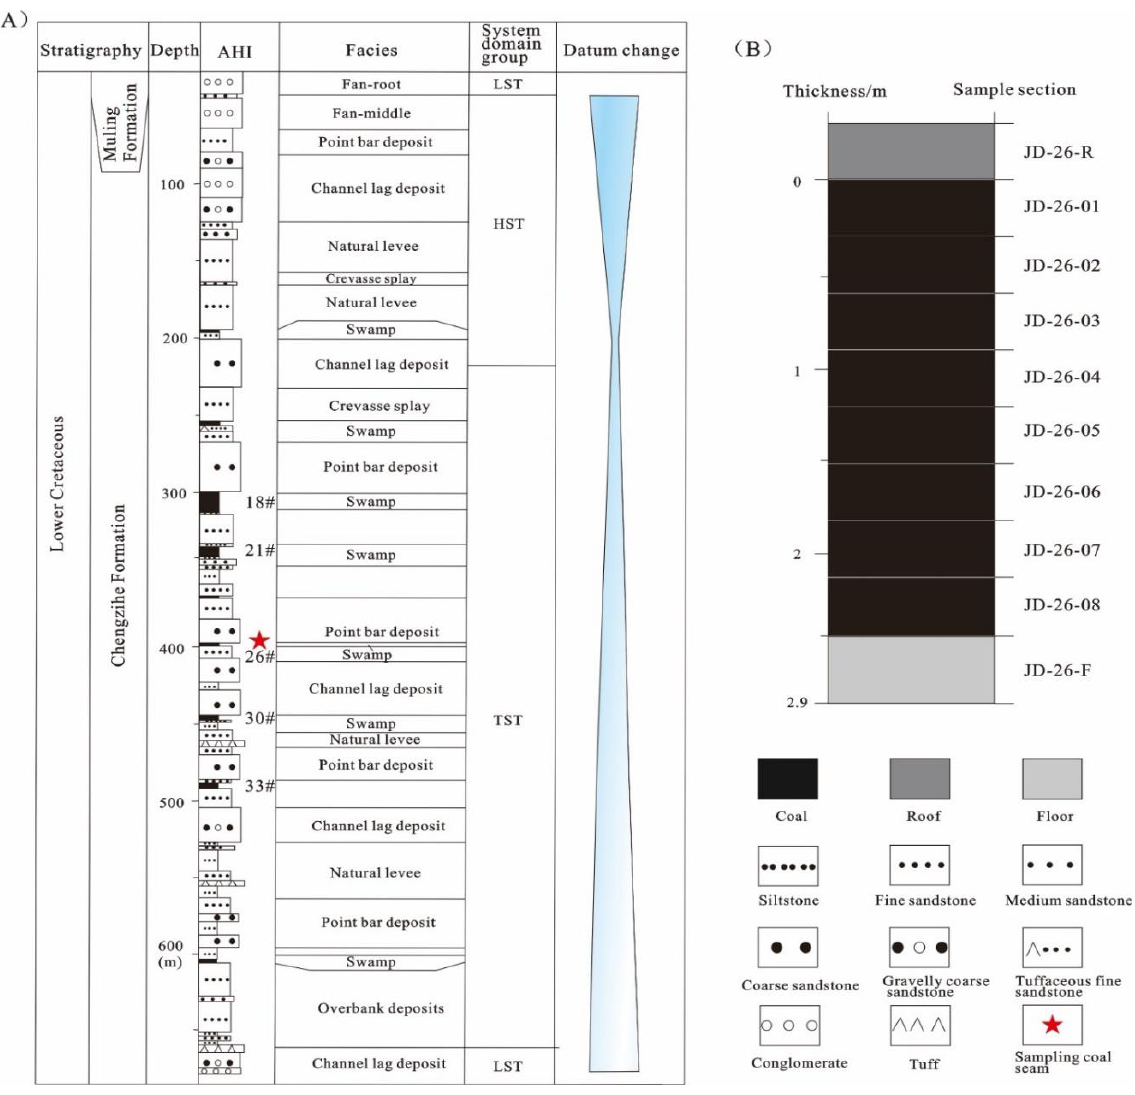
Figure 2. ( A ) The strata histogram (modified after [38]) and ( B ) sampling profile from Junde mine, Hegang coalfield.